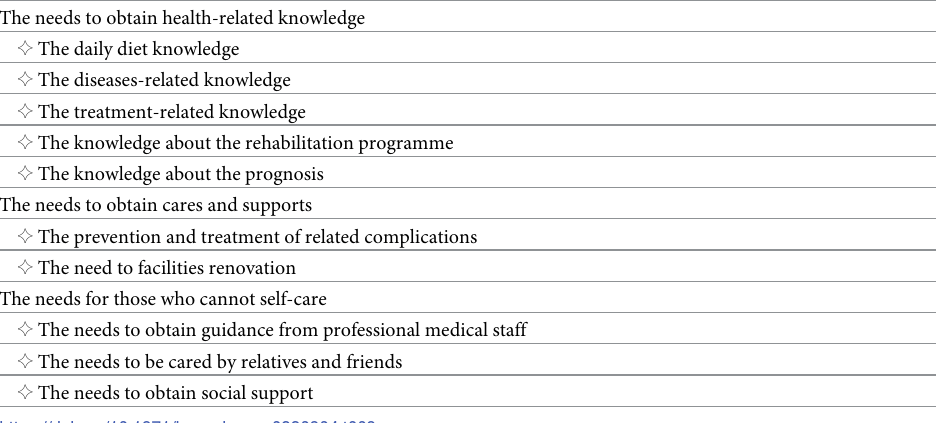
Table 3. The themes and subthemes associated with needs of home-based rehabilitation. The needs to obtain health-related